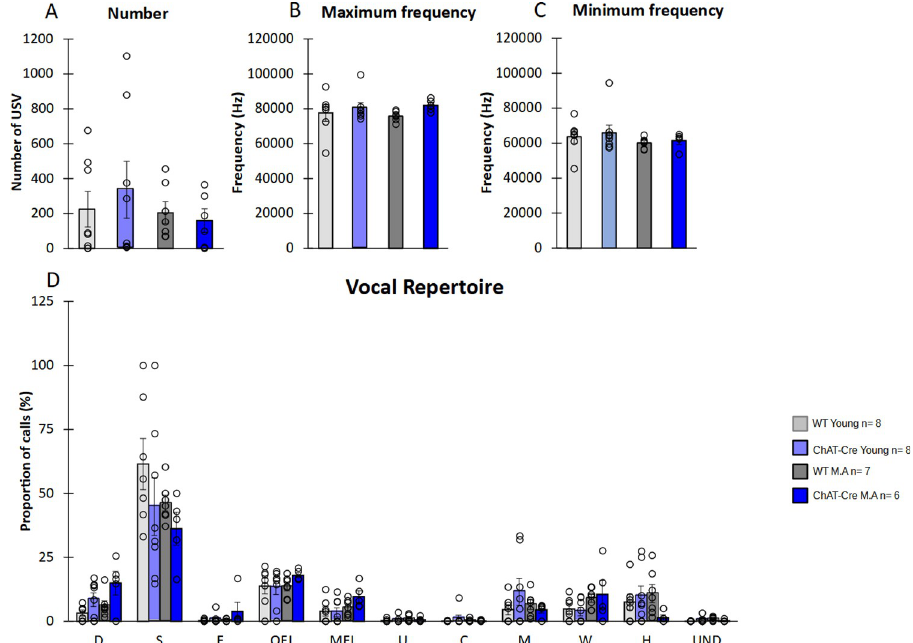
Fig 4. Ultrasonic vocalizations (USVs) emitted during SIT. A) Number of USV. B) Maximum frequency of USVs. C) Minimum frequency of USVs. D) Diversity of USVs recorded. WT young n = 8, ChAT-Cre young n = 8, WT Middle Age n = 8, ChAT-Cre Middle Age n = 7. Visitor mice (young n = 6 and middle age n = 6). Data are presented as means ± SE; � p < 0.05; �� p < 0.01; ��� p < 0.001; Kruskal-Wallis rank-sum test analysis then Wilcoxon and d signed- rank tests were applied when appropriate. # represents the genotype effect and ◆ the age effect. Kruskal-Wallis results were not represented for